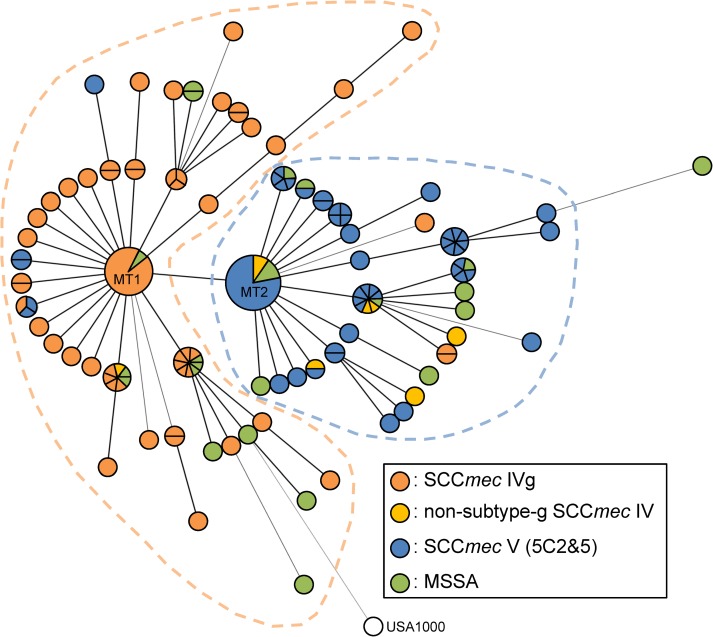
Minimum spanning tree of CC59 S. aureus strains constructed by MLVA.Each circle represents an MLVA type. Circles or sectors of circles with orange, yellow, blue or green colors denote SCCmec IVg MRSA, non-subtype-g SCCmec IV MRSA, SCCmec V (5C2&5) MRSA or MSSA, respectively. The USA1000, which is ST59 MRSA in the United States, is shown in white. The size of each circle is proportional to the number of strains.